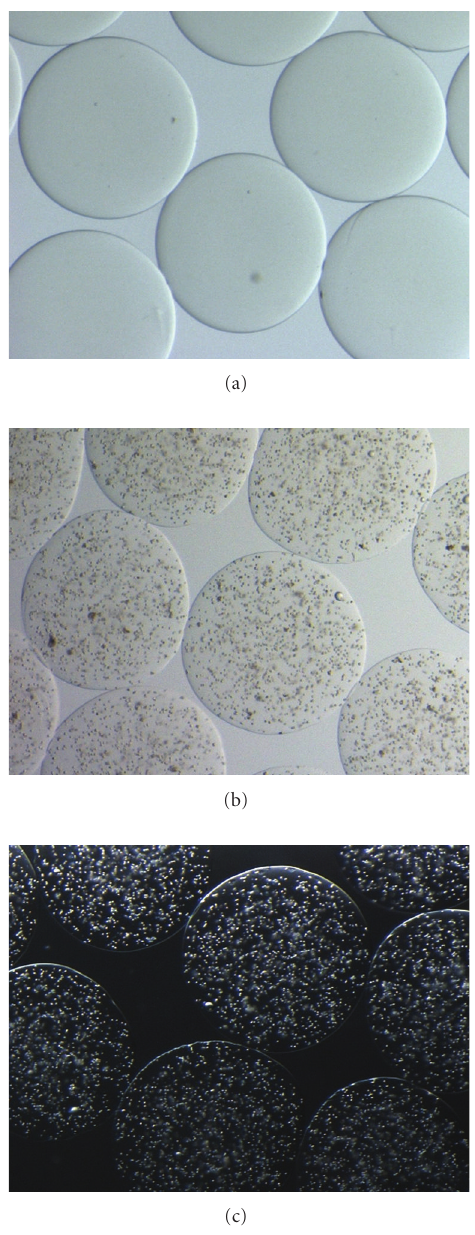
Figure 3: Bright field (a,b) and dark field (c) stereophotomi- crographs of empty (a) and IB3-1 containing (b,c) alginate microbeads. Microbeads were produced by the monojet air-driven device. Alginate microbeads were prepared using the experimental parameters reported in Table 1 (batch #15a, b,